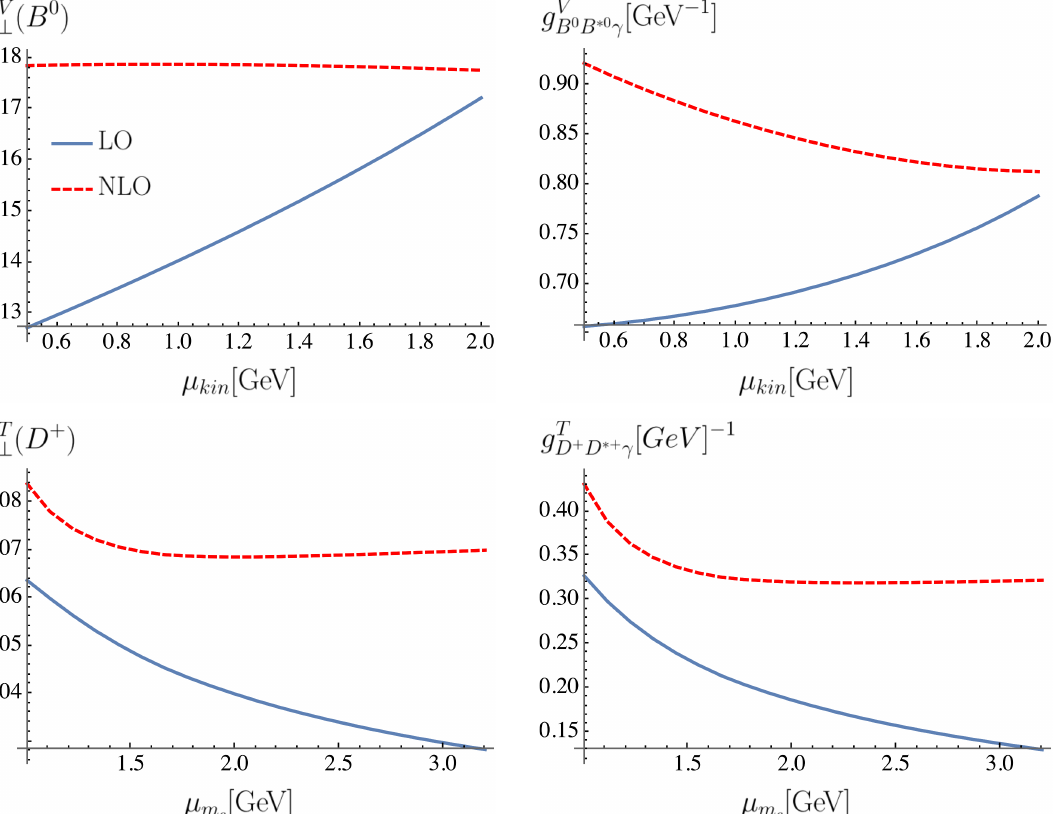
Figure 2 . Representative plots highlighting how the NLO result (dashed red) sees a reduction in the mass scheme scale µ kin ( µ ) as compared to LO (solid blue). We note that in the B -meson case MS the residue generally shows greater stability than the coupling which, in the above cases, inherits the (artificial) scale dependence of f B ∗ which is less pronounced for f D ∗ as the plots